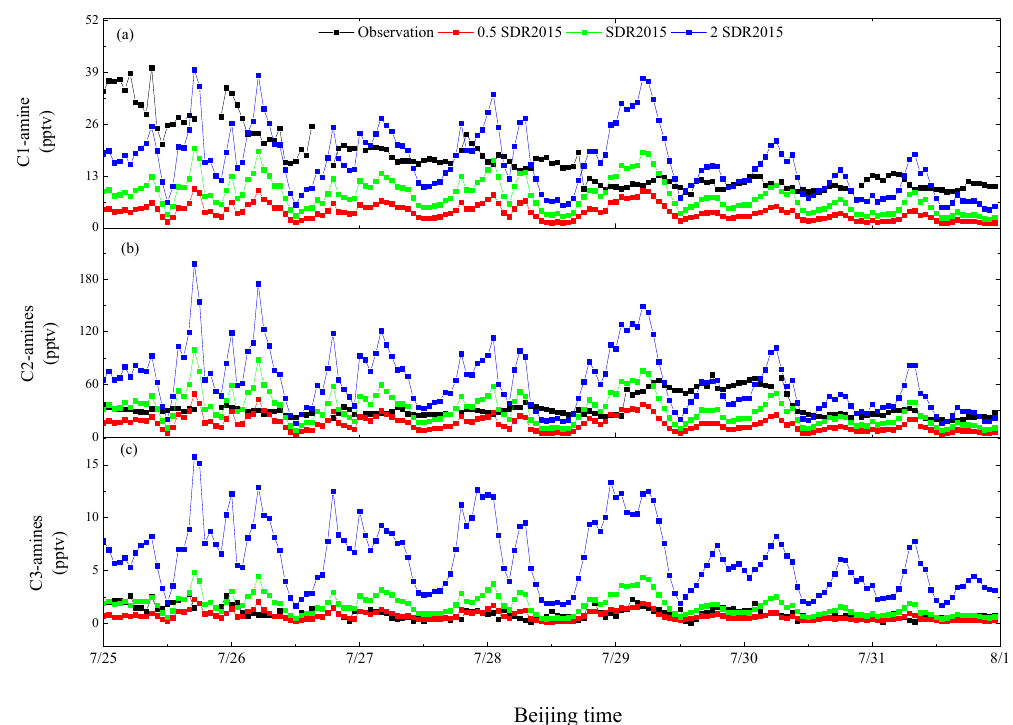
Beijing time Figure 8. Same as Fig. 7 but for 0.5 SDR2015, SDR2015, and 2 SDR2015 (domain 4) at the Fudan site from 25 to 31 July 2015. Table 5. Variations in normalized mean biases (NMBs) of methylamine simulations when amine emission rates are halved or doubled, at the NUIST site (SDR2012, 0.5 SDR2012, 2 SDR2012) in domain 3 and the Fudan site (SDR2015, 0.5 SDR2015, 2 SDR2015) in domain 3 and domain 4 (values given in